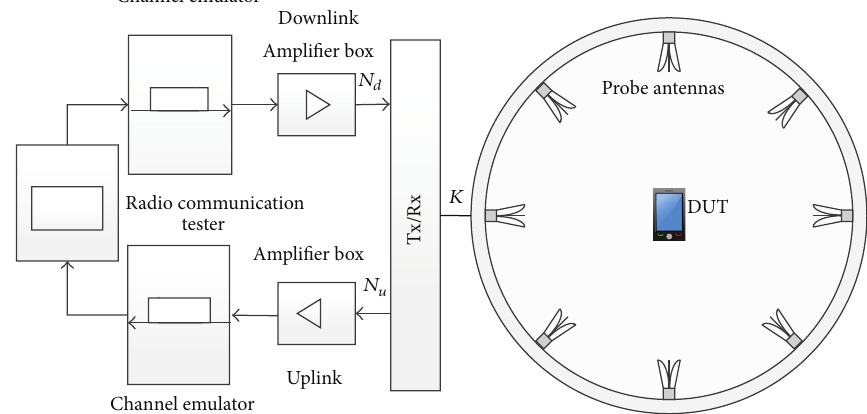
Figure 6: An example of a symmetric MPAC setup that supports emulating both uplink and downlink channels. 𝑁 𝑑 and 𝑁 𝑢 probes are used for the downlink and uplink, respectively, with 𝑁 𝑢 ≦ 𝑁 𝑑 ≦ 𝐾 . Note that the same probe can be used for transmitting in the downlink and receiving in the uplink with the help of a circulator.